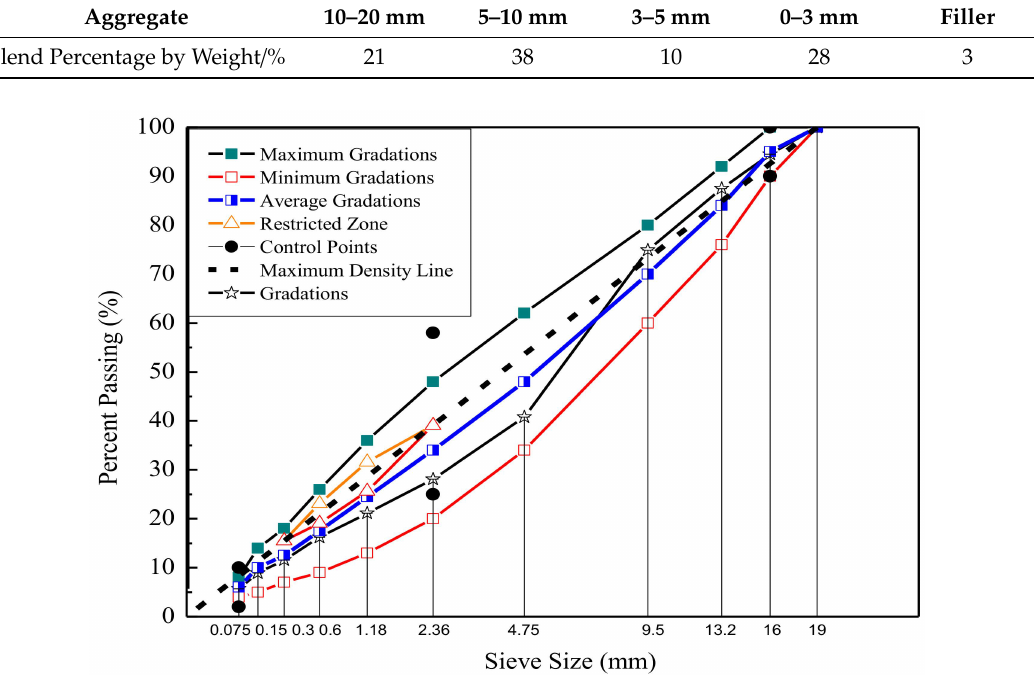
Table 1. Aggregate blend percentages [24].